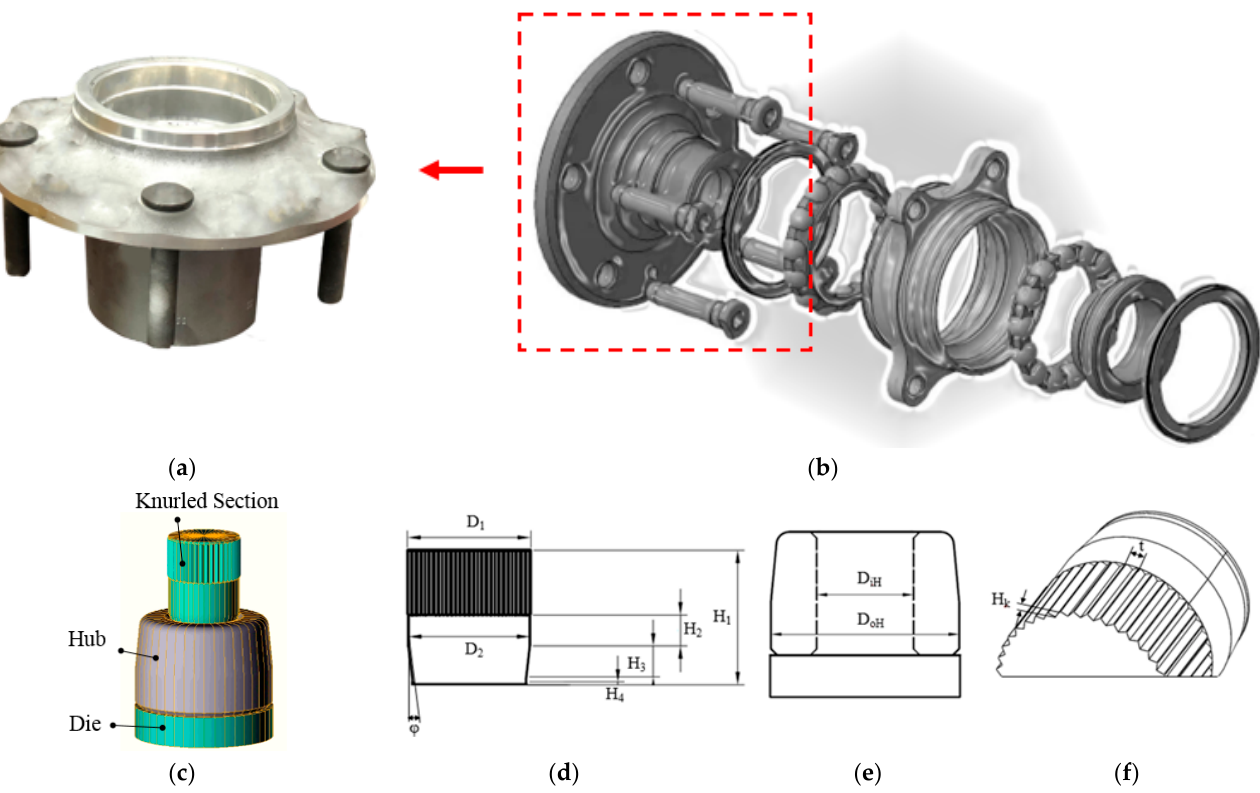
Figure 1. The main research items of this paper: ( a ) the workpiece of the hub structure, ( b ) the expanded view of the wheel structure, ( c ) 3D drawing of the structure, ( d ) the view of the shaft design dimensions, ( e ) the side view of the hub design dimensions, and ( f ) the design dimensions of the knurl area. Table 1. Chemical composition of AA6061.